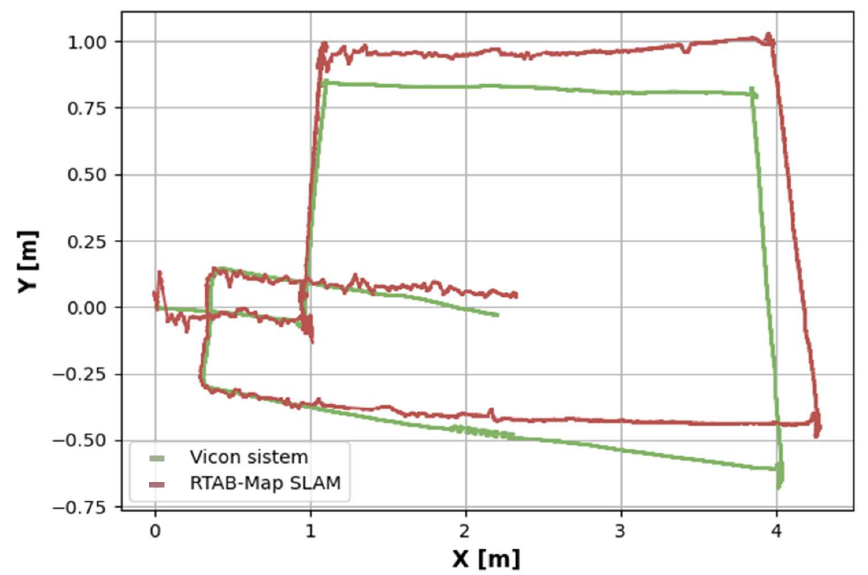
Figure 5. Comparison of RTAB-SLAM localization against trajectory obtained with motion cap- ture